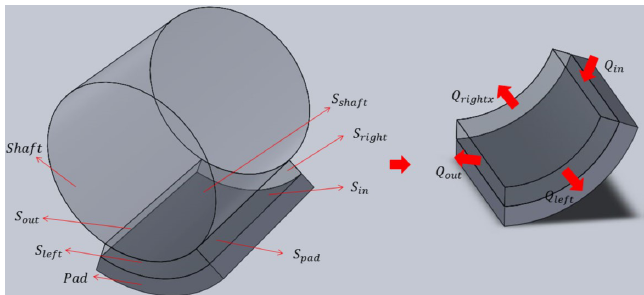
Figure 3. Control volume of the oil